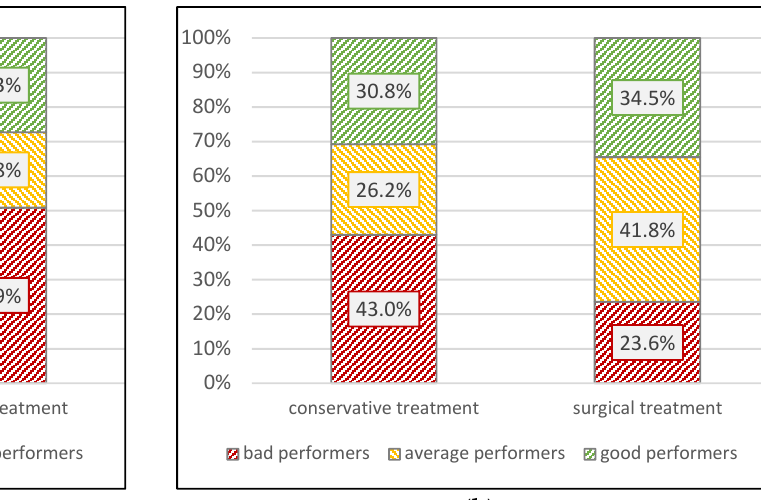
Figure 5. Distribution of good, average, and bad performers (NDI and ROM T2D tertiles) stratified by group. ( a ) Group Neck Disability Index (NDI) performance; ( b ) Group performance in Range of Motion (ROM).